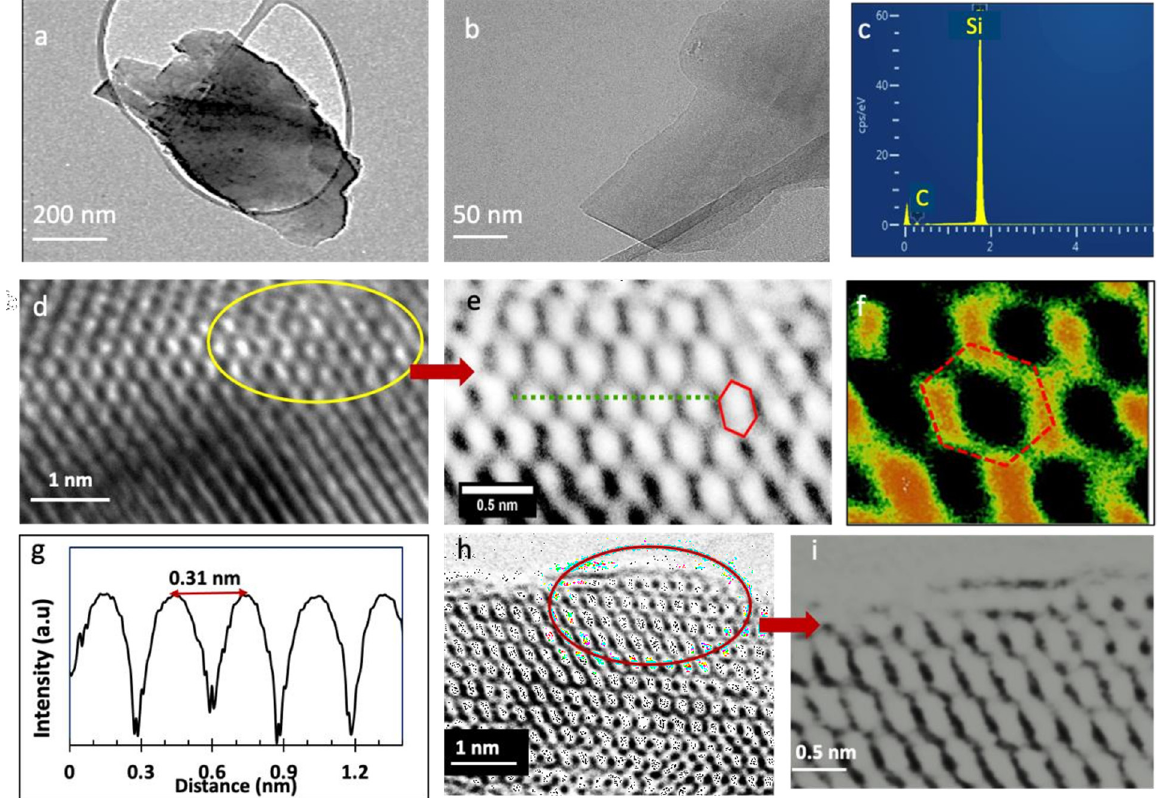
Figure 3. TEM characterization of exfoliated SiC nanosheets. ( a, b ) Low magnification bright-field TEM images of SiC nanosheets. ( c ) EDX analysis (by TEM) of the nanosheet shown in ( b ). ( d – f,h,i ) high- resolution TEM images of the ordered structure of the SiC nanosheets. ( g ): Intensity distributions along dotted lines shown in Figure 3h.